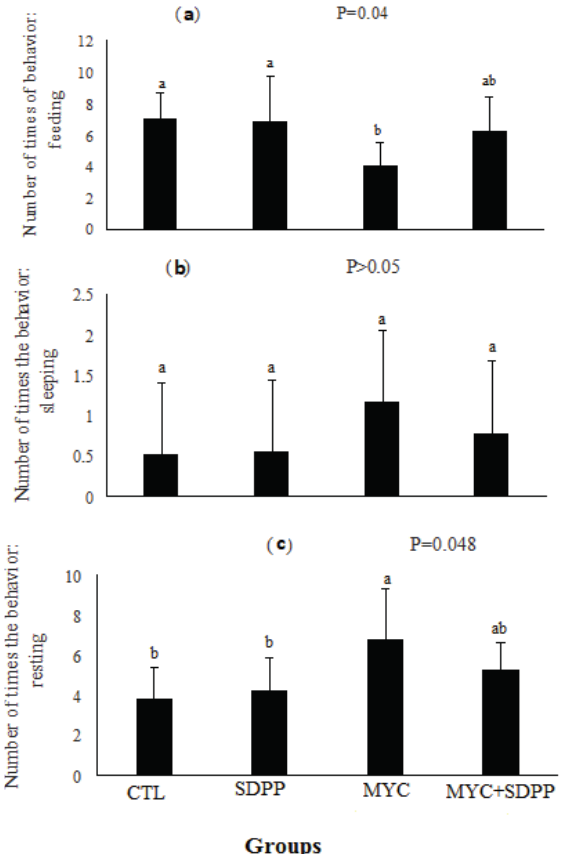
Figure 3 - effect of mycotoxins and spray-dried porcine plasma (SDPP) on the behavior (Y-axis) evaluated on days 5, 10 and 15 of experiment to number of behavior: feeding ( a ), sleeping ( b ) and resting ( c ). Ctl group: control diet; SDPP group: control diet and 6% of SDPP; MYC group: 210 µg/kg aflatoxins and 6.690 µg/kg fumonisins; MYC+SDPP group: 253 µg/kg aflatoxins, 6.930 µg/kg of fumonisins and 6% SDPP. Results show mean and standard deviation. Groups with equal letters (a, b) in the same graph do not differ statistically from each other